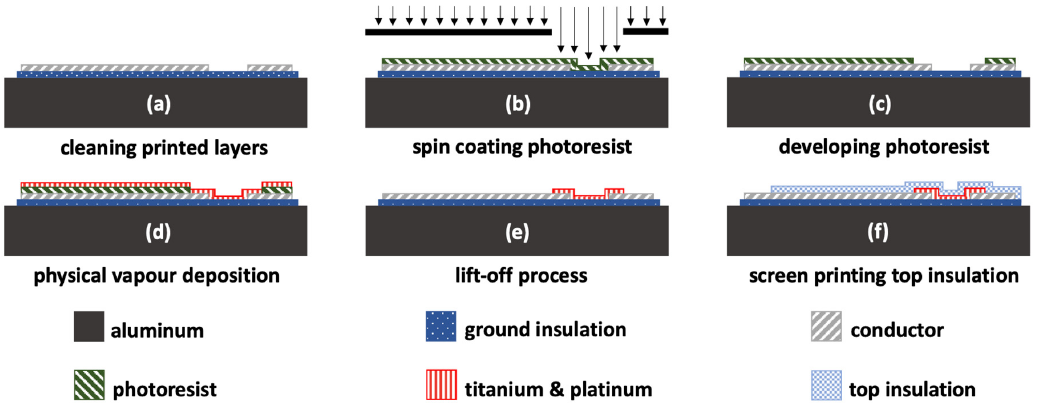
Figure 3. The schematic micro structuring process of the thin-film strain gauge on a thick-film surface with a subsequent screen printed top insulation step.